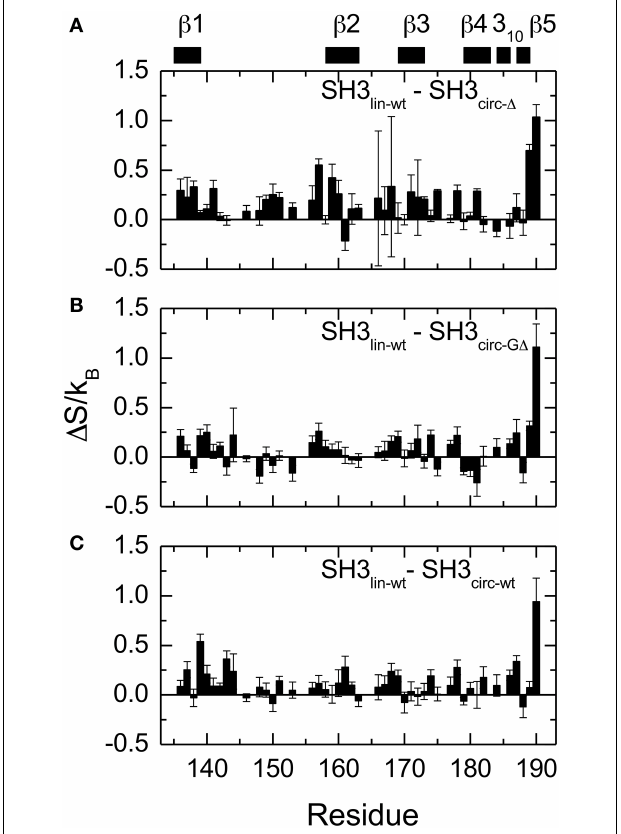
FIGURE 8 | Differences in the NH contributions to backbone entropy between the linear and circular SH3 constructs, on a per residue basis. (A) SH3 lin - wt – SH3 circ - 1 ; (B) SH3 lin - wt – SH3 circ - G 1 ; and (C) SH3 lin - wt – SH3 circ - wt .